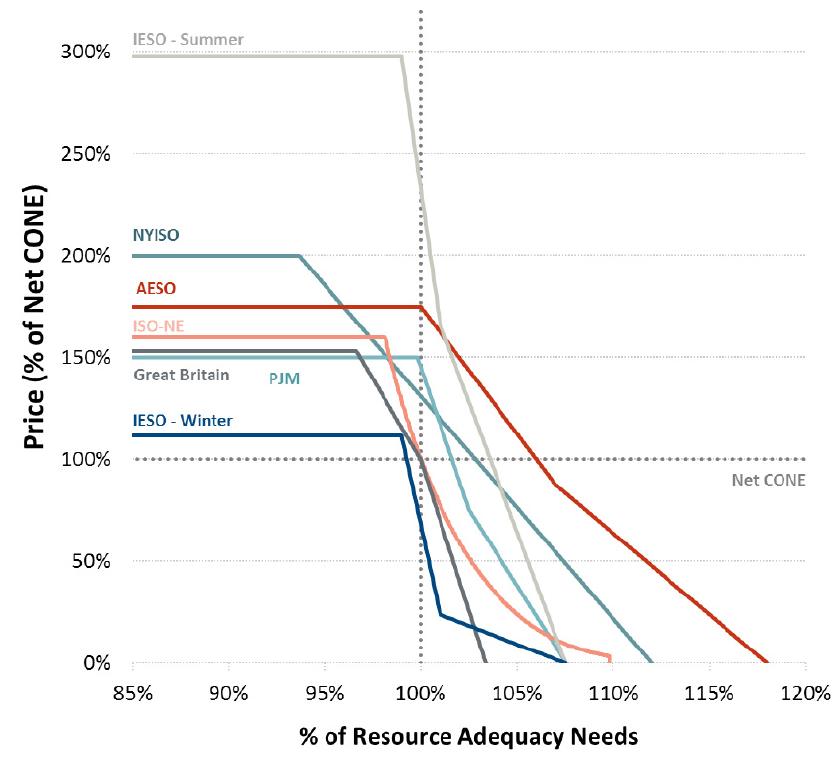
Figure 1. Comparison of demand curves.